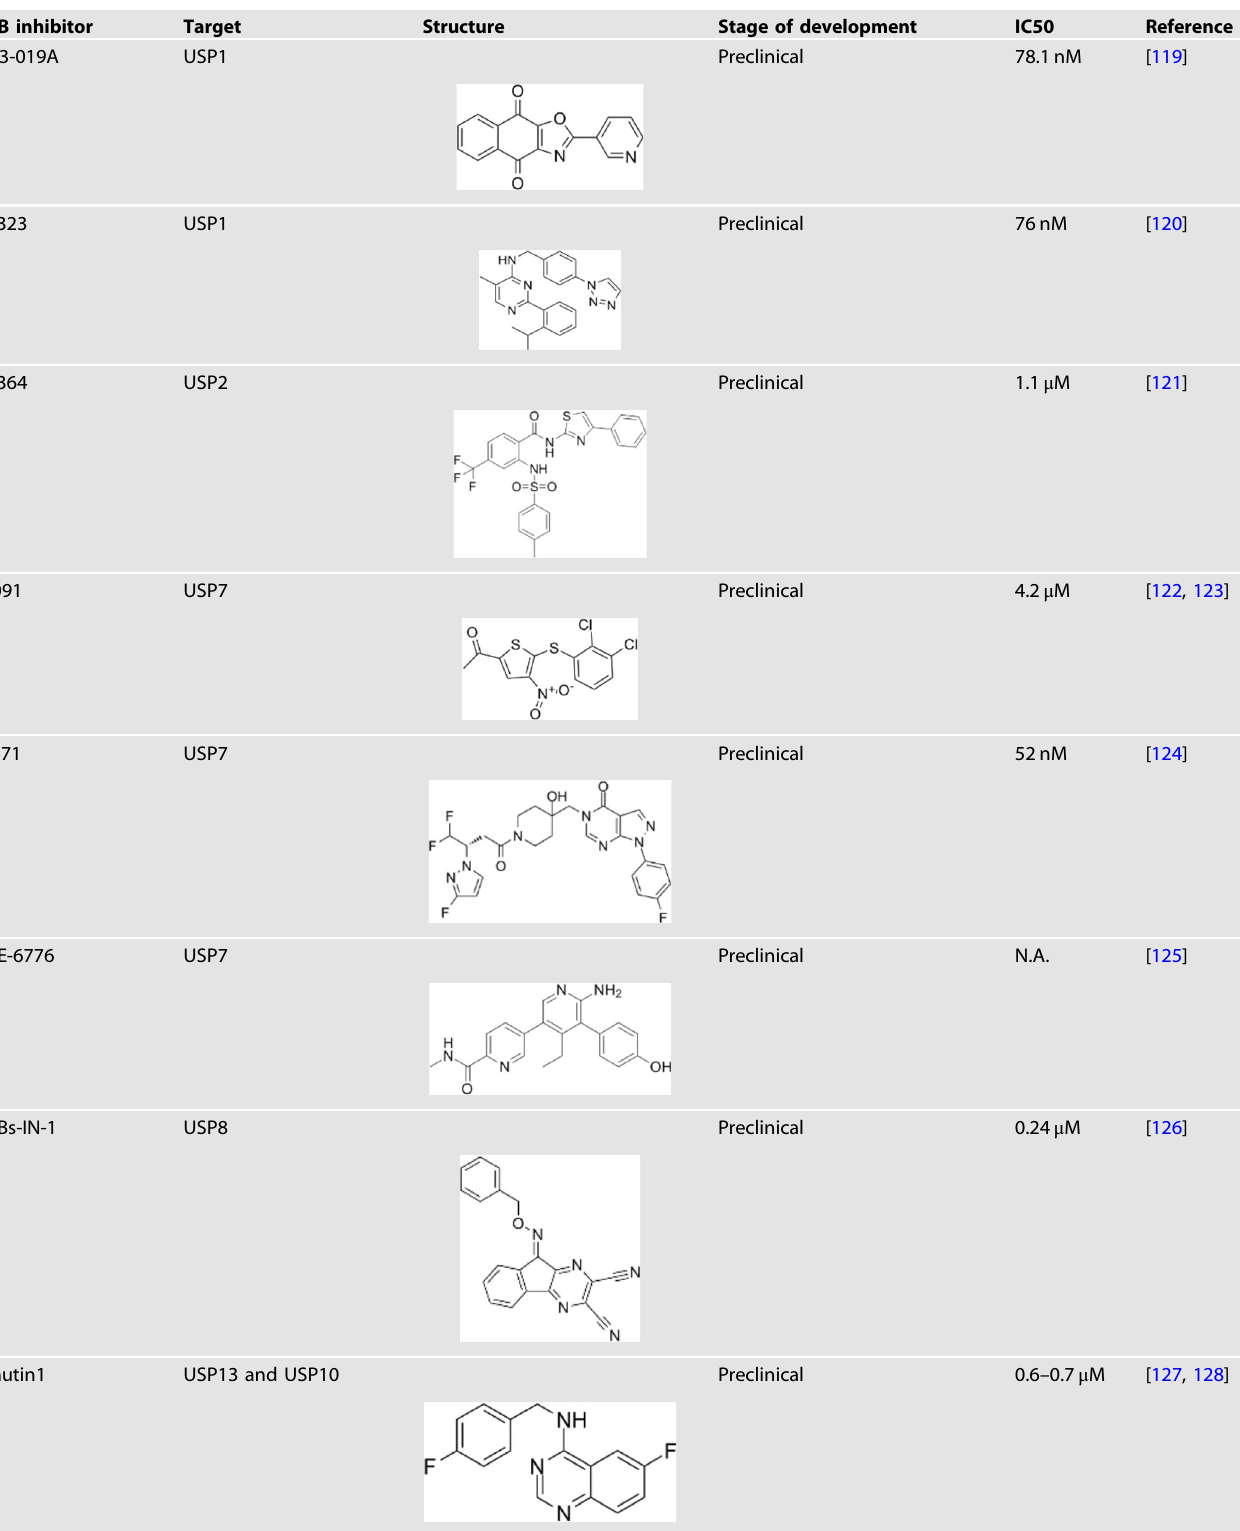
Table 2. Other representative inhibitors of